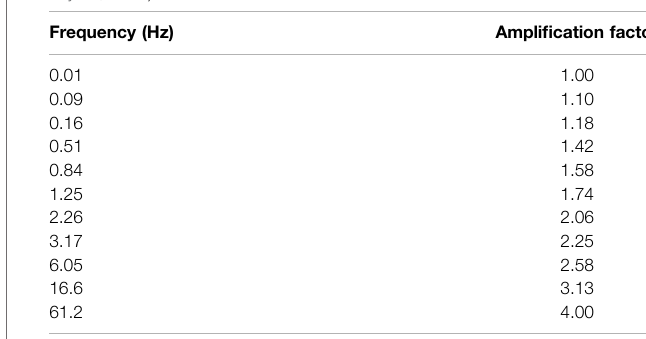
TABLE 3 | Crustal site ampli fi cation elements used in the simulations (Boore and Joyner,